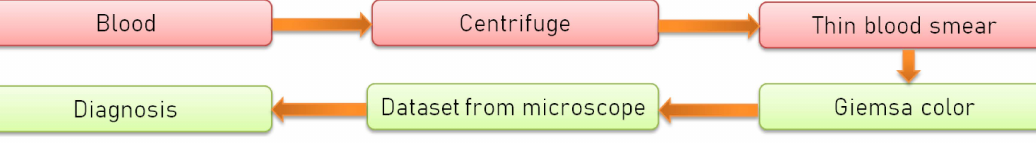
Figure 1. The dipstick